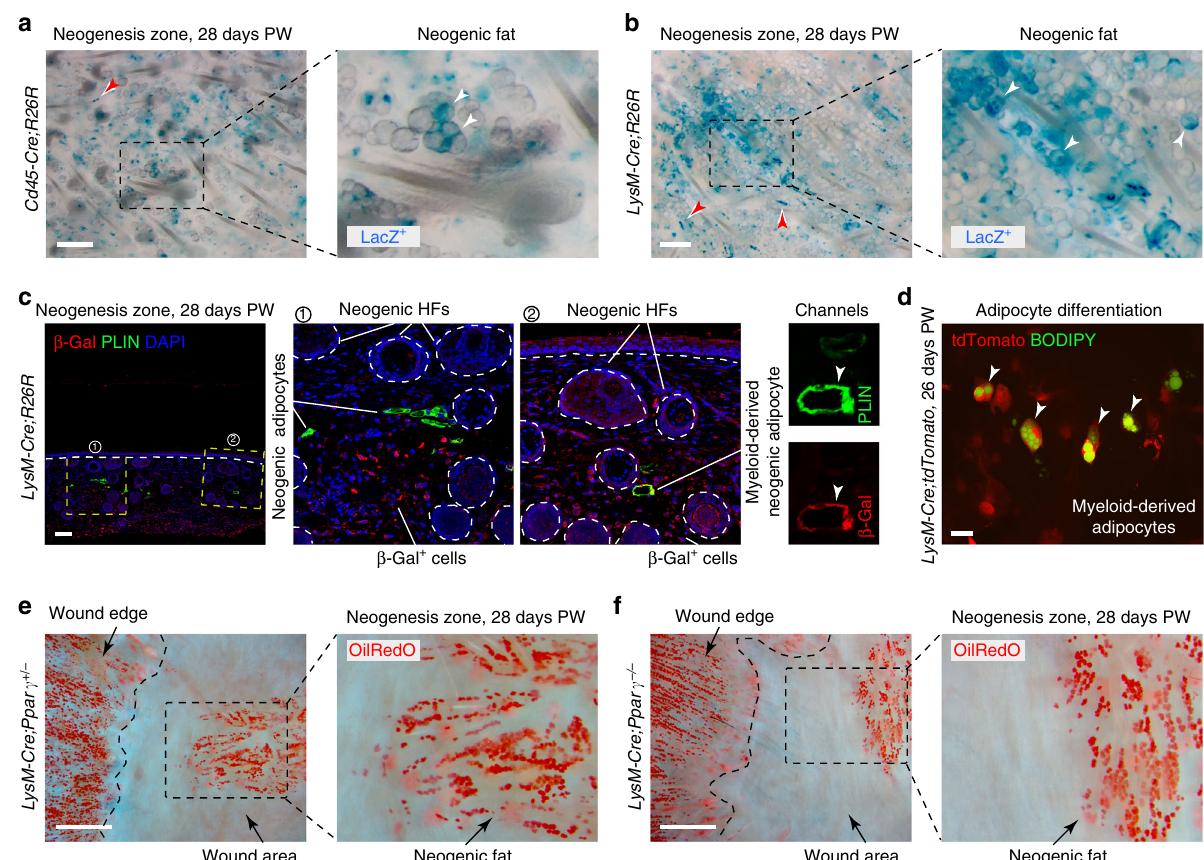
Fig. 8 Myeloid lineage cells contribute to rare de novo adipocytes. a , b LacZ + clusters of de novo adipocytes (white arrowheads) were consistently identi fi ed in the wounds of pan-hematopoietic speci fi c Cd45-Cre;R26R ( a ) and myeloid-speci fi c LysM-Cre;R26R mice ( b ). Red arrowheads mark lacZ + DPs of neogenic hair follicles. See also Supplementary Figure 20. c Co-staining of day 28 LysM-Cre;R26R wounds for β -Gal (red) and PLIN (green) identi fi ed both single-positive (inset 1) and double-positive mature adipocytes (inset 2) in the region of neogenesis. Image is representative of the marker staining patterns observed in three or more independently stained samples. d Lipid-laden adipocytes (BODIPY + , green) can be differentiated in vitro under adipogenic conditions from tdTomato + cells (red), isolated from day 26 hair-bearing wounds from LysM-Cre;tdTomato mice. e , f In agreement with the limited lineage contribution from myeloid cells toward de novo adipocytes LysM-Cre;Ppar γ − / − mutants regenerated nearly normal-looking de novo fat (compare mutant wound on f with heterozygous control on e ). Adipocytes were stained red with OilRedO. PW: post-wounding, HF: hair follicle. Size bars: a , b — 200 µ m; c — 100 µ m; d — 25 µ m; e , f — 1